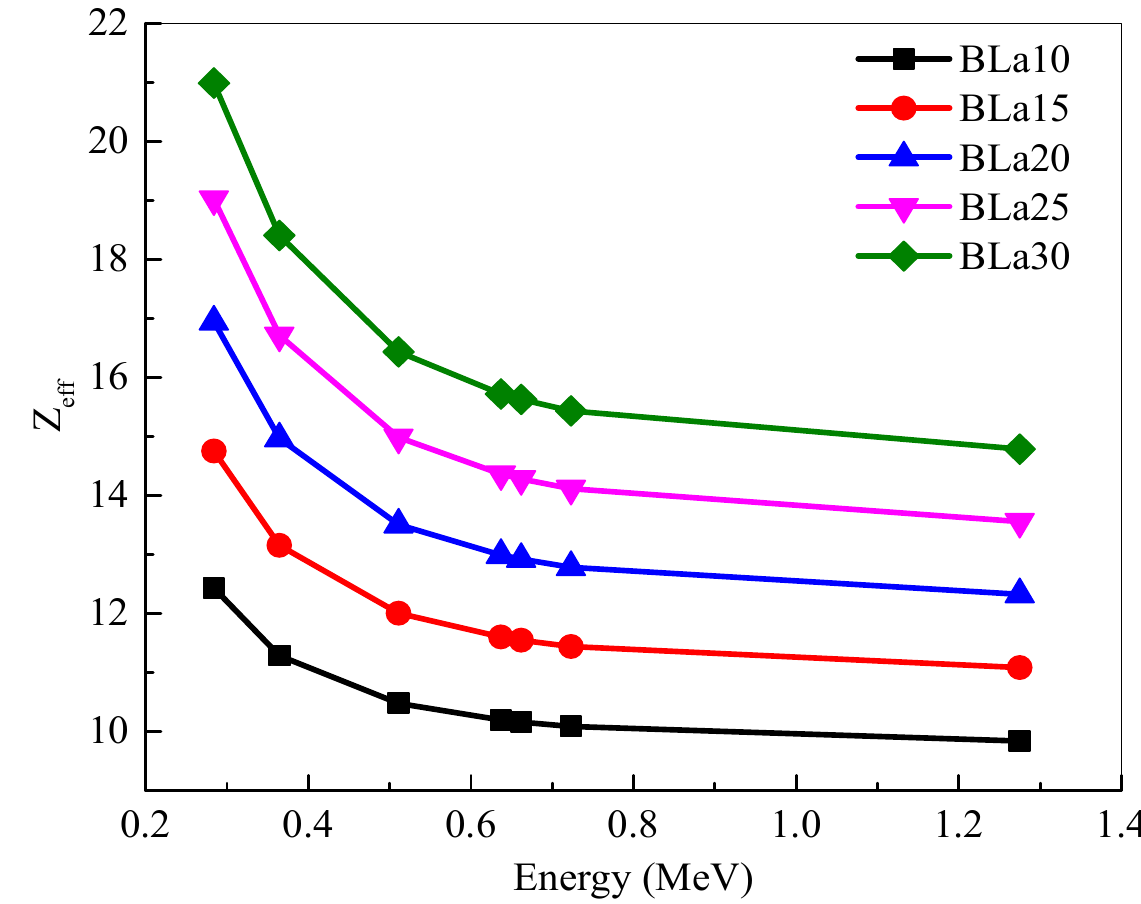
Figure 4. Effective atomic number ( Z eff ) of the shielding samples at 0.284, 0.3645, 0.511, 0.637, 0.6617, 0.723 and 1.275 MeV. The HVL of the BLa-X glass shields were investigated at selected energies and in Figure 5. One must remember that a lower HVL signifies a more space-efficient shield. The minimum HVL values are found at 0.284 MeV, which is as expected. Figure 5 demonstrated that BLa30 has the least HVL and BLa10 has the greatest, which means that BLa30 is the most space-efficient shield. As energy increases, the HVL s of the glasses increase as well. The HVL of BLa10 increases from 1.646 (for E = 0.284 MeV) to 4.268 cm (for E = 1.275 MeV), but it is increased for BLa30 from 1.083 to 3.499 cm for the same respective energies. Since energy and HVL are directly correlated, the maximum HVL can be found at the highest selected energy, 1.275 MeV. This positive trend occurs since, as the photon energy